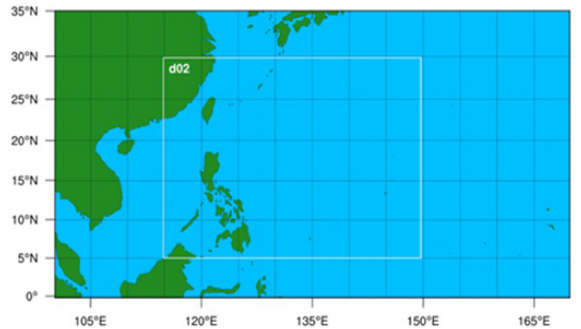
Figure 1. Study domain setup. The outer 25km resolution ( (cid:49)x ) do- main is bounded by 0–35 ◦ N and 100–170 ◦ E, while the inner 5km resolution ( (cid:49)x ) domain is bounded by 5–30 ◦ N and 115–150 ◦